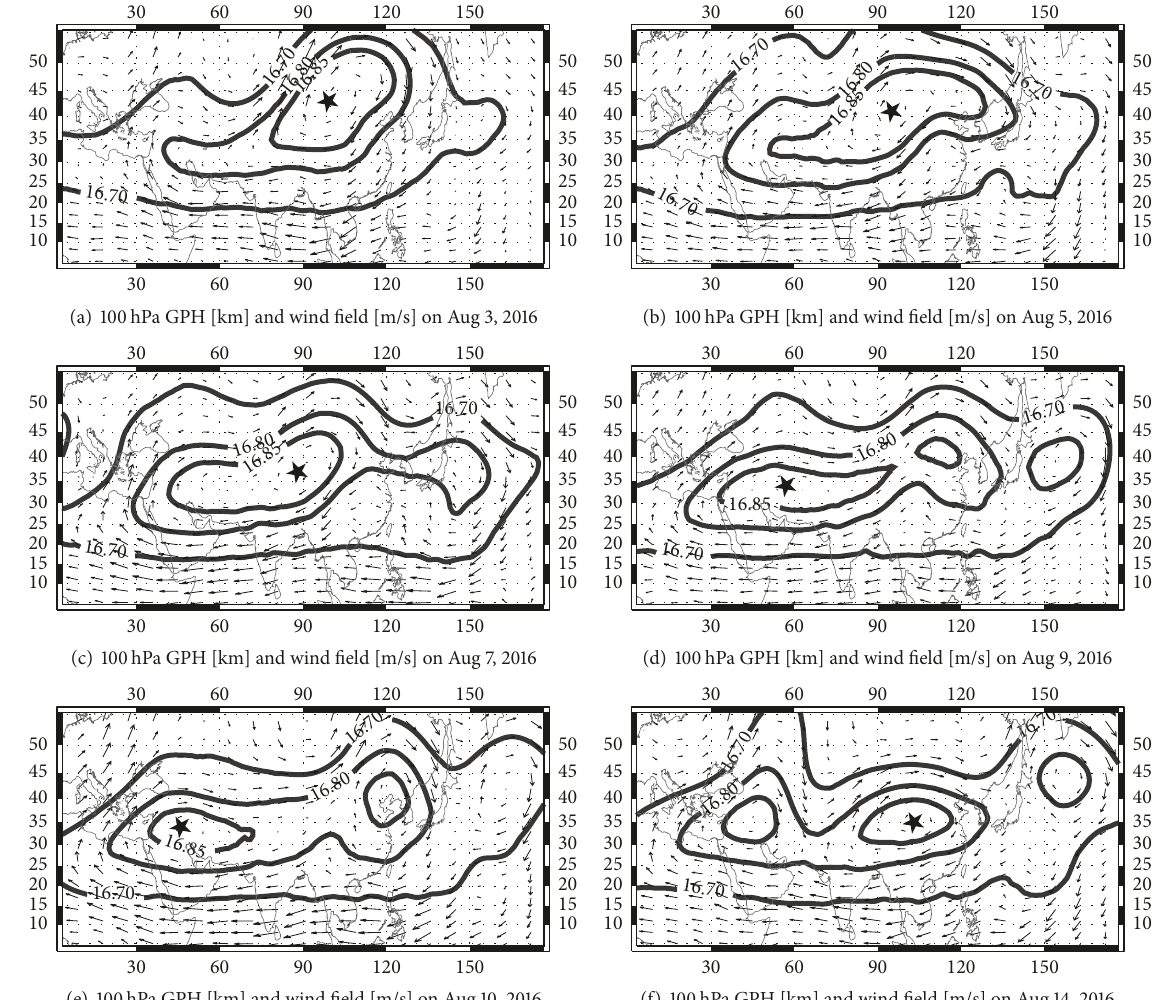
Figure 1: Daily maps of geopotential height (GPH, thick contour) and horizontal wind field (vectors) at 100hPa on (a) Aug 3, (b) Aug 5, (c) Aug 7, (d) Aug 9, (e) Aug 10, and (f) Aug 14, 2016. The GPH contours are 16.70 km, 16.80km, and 16.85 km. The five-pointed star indicates maximum of GPH in the Asian summer monsoon region (10–40 ∘ N, 30–150 ∘